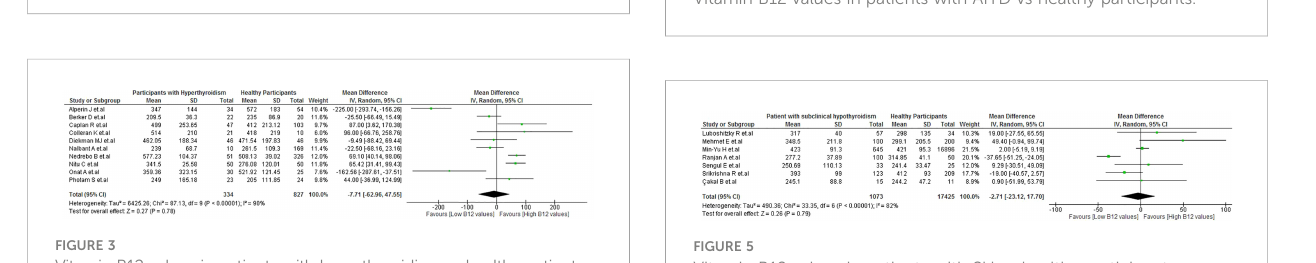
FIGURE 4 Vitamin B12 values in patients with AITD vs healthy